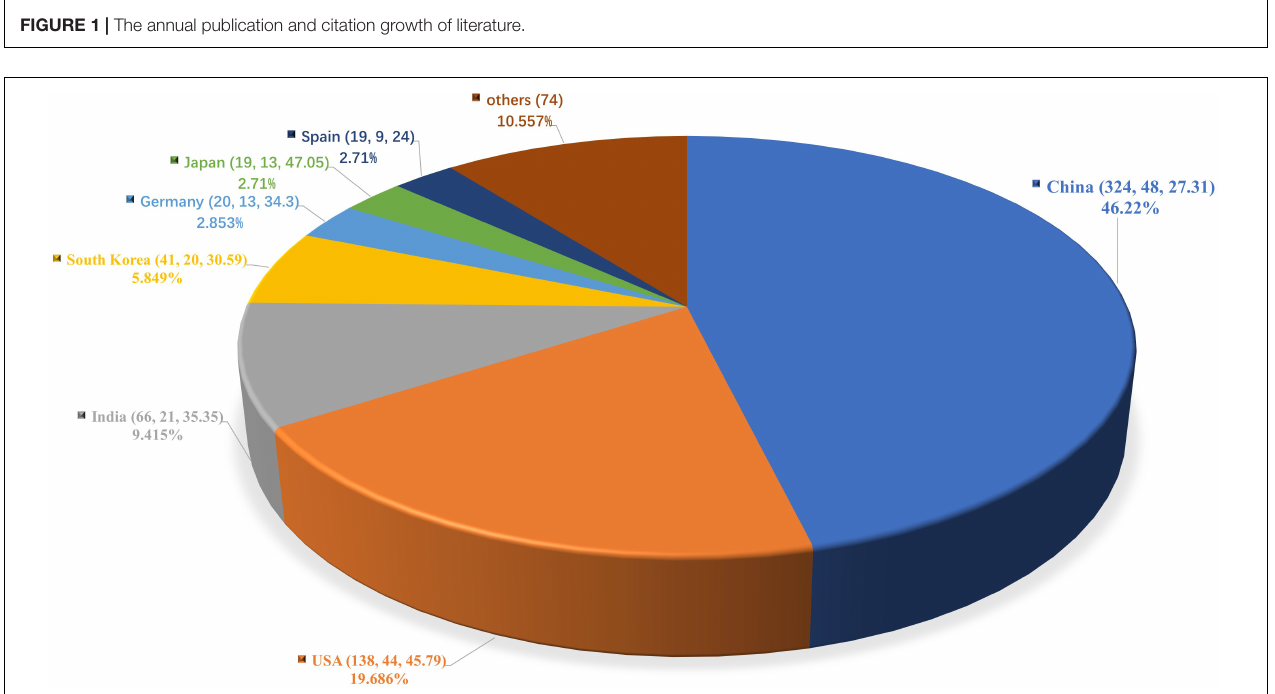
FIGURE 2 | Distribution of publications in countries/regions. The number in the brackets goes: (publication numbers, h-index, average citations). Percentage indicates the proportion of the publication number in global